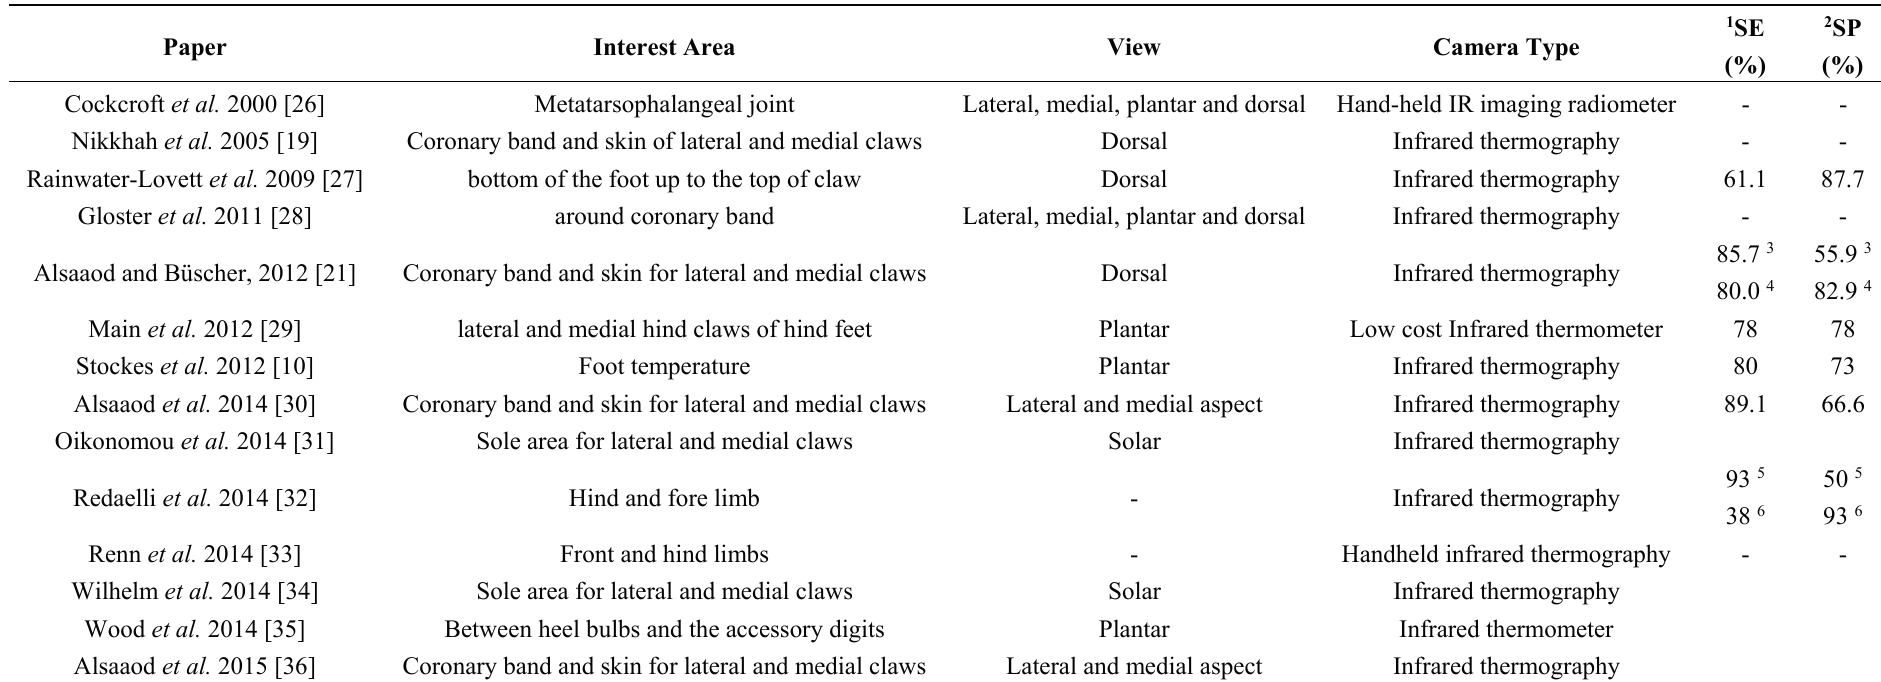
Table 1. Peer-reviewed published studies carried out from 2000 onward that used thermography for lameness detection in